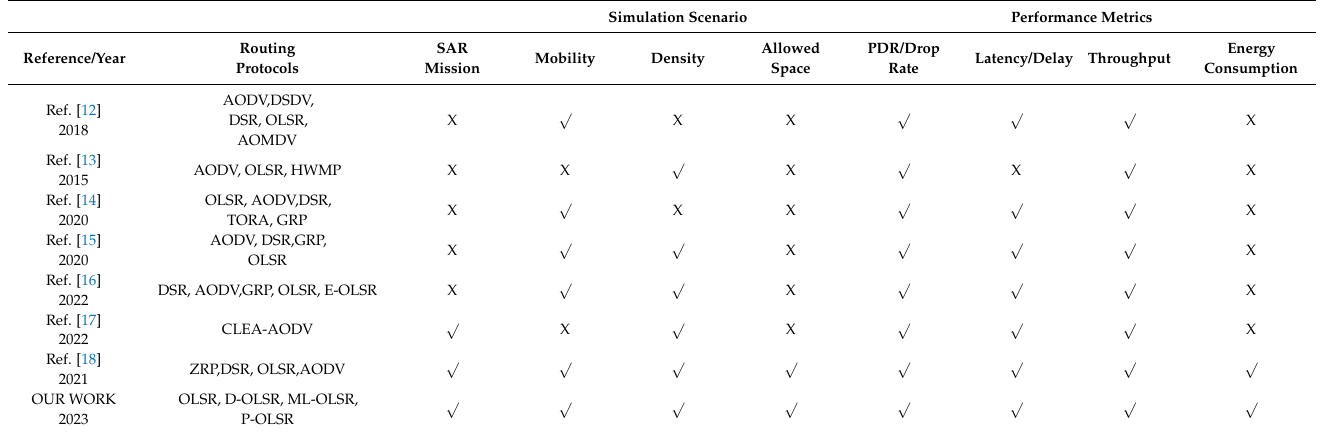
Table 1. A comparison of related works with this